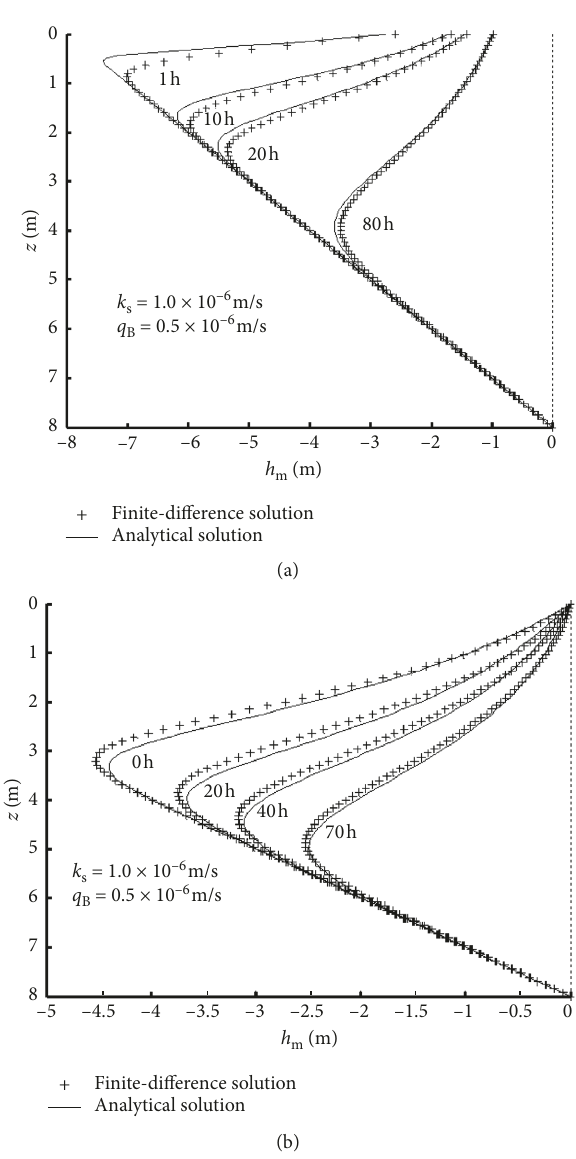
Figure 2: Distribution of suction head with depth at different